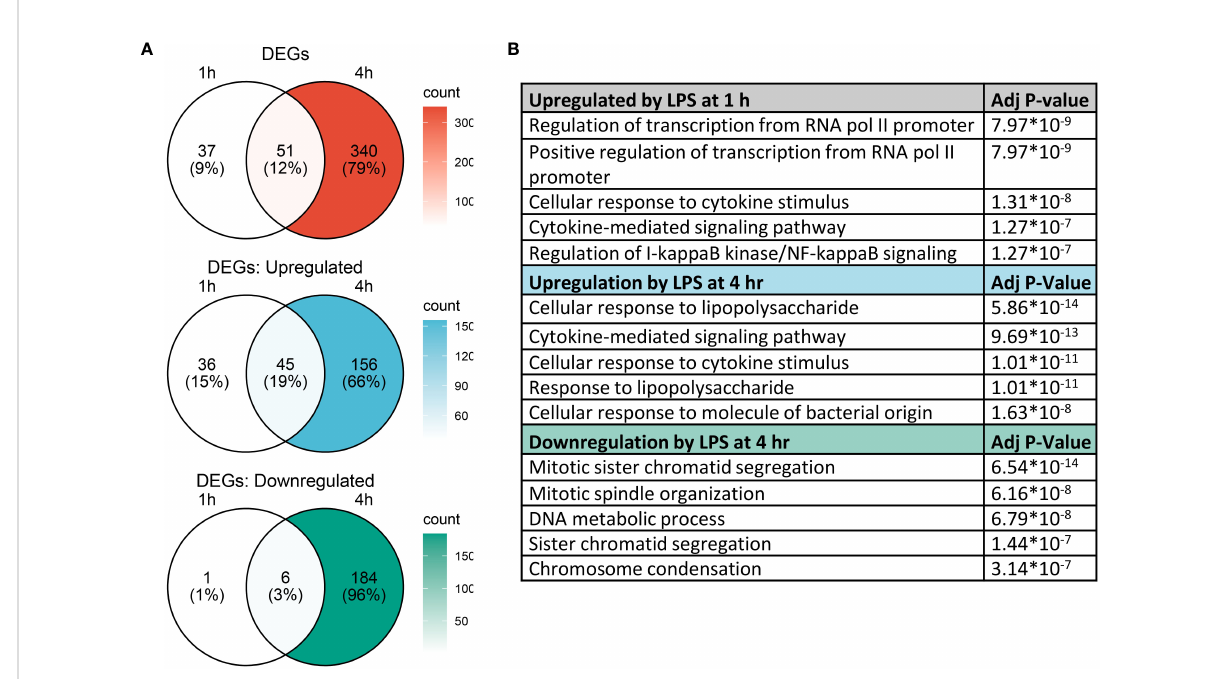
FIGURE 5 Gene expression changes induced by LPS in FLMs at 1 and 4h. (A) Differentially expressed genes (DEGs) were identi fi ed using the Seurat FindMarkers function, with thresholds set to select genes with >2-fold change in gene expression and genes expressed in at least half of either group being compared. Venn diagrams of DEGs at 1h only (left circle), 4h only (right circle), and at both timepoints (intersection) were generated to visualize the quantity of DEGs in each group. (B) The Enrichr database was used to identify GO Biological Process terms for the indicated groups of genes. Shown are the fi ve most enriched pathways upregulated by LPS after 1 and 4 h or downregulated by LPS after 4 h, as determined by the size of the adjusted p